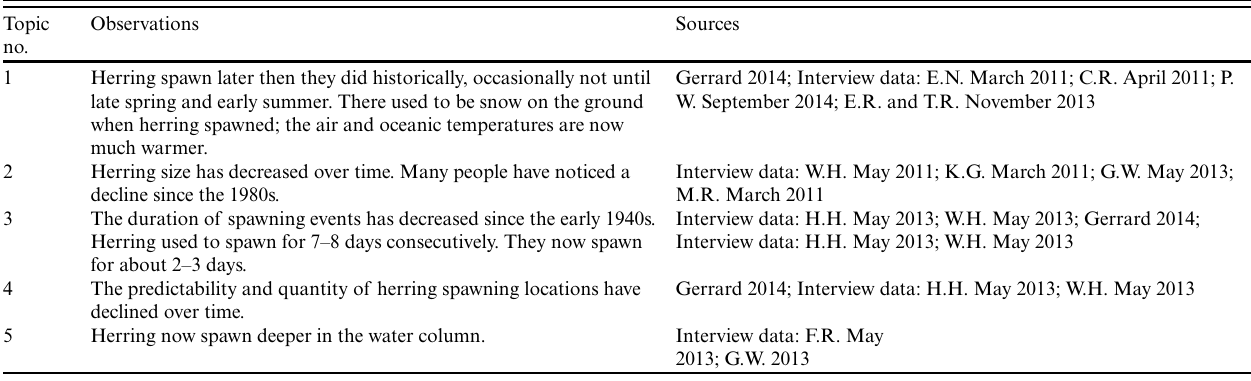
Table 2 . Recent observations about Pacific